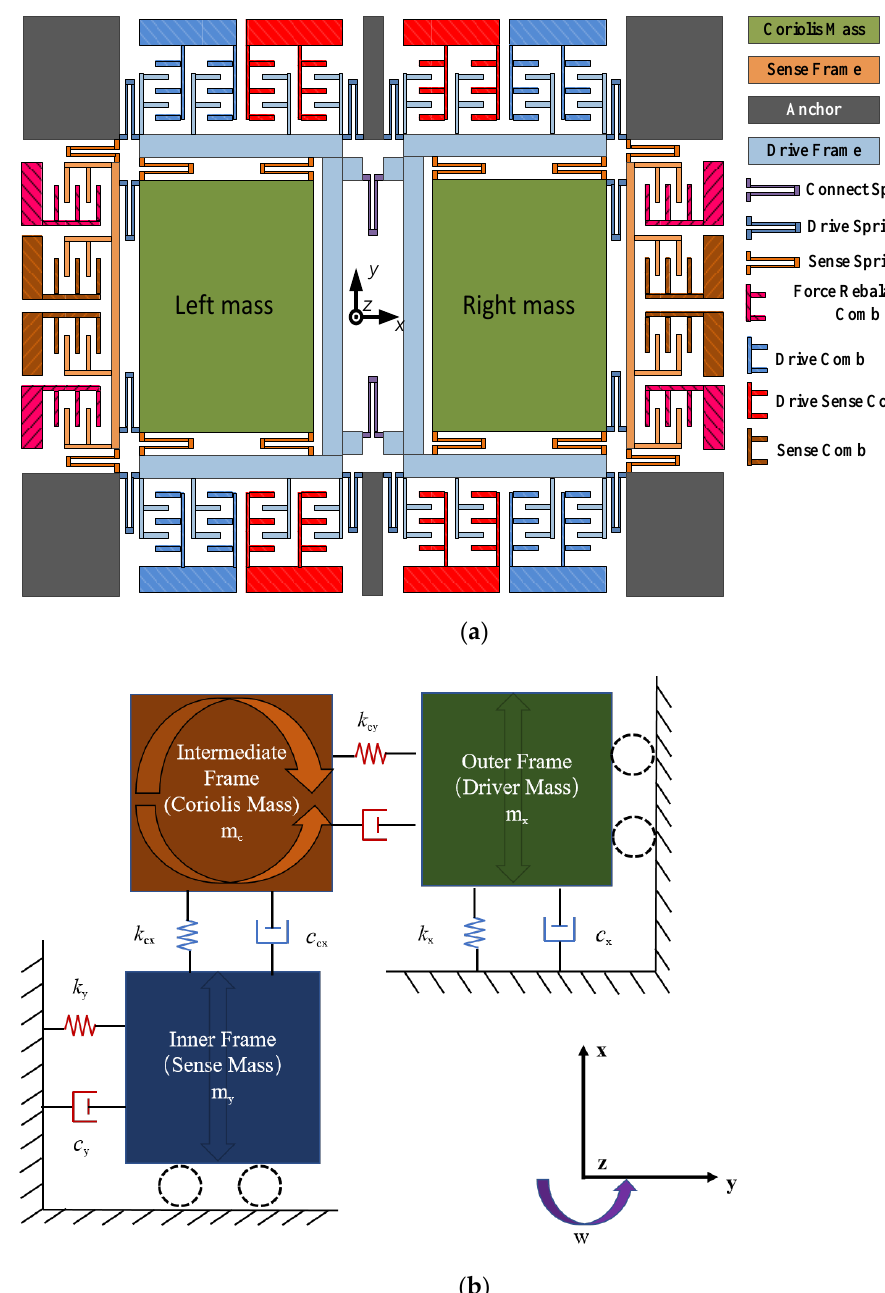
Figure 1. ( a ) The gyroscope’ structure; ( b ) The gyroscope’ mechanical model. The gyroscope works on the basis of tuning fork theory. The U-type connecting spring is connected to the dual-drive mass block, and the drive spring is connected to the dual- sense mass block. In order to analyze the gyroscope’s working modes, Ansys Soft- ware (ANSYS, Pittsburgh, PA, USA) is adopted to simulate these working modes; the re- sults are shown in Figure 2 [30]. It can be found that the frequency gap between the first and the fourth working mode is large, which is more than 1000 Hz, and the fourth mode of the gyroscope has a quality factor of more than 2000, so the fourth mode is the gyro- scope drive mode. Figure 2a – d show the analysis results of the gyroscope’s four working modes in turn. The drive in-phase mode is the first mode, in which the vibration direction of the double mass of the gyroscope is consistent with the X-axis. The second mode is the